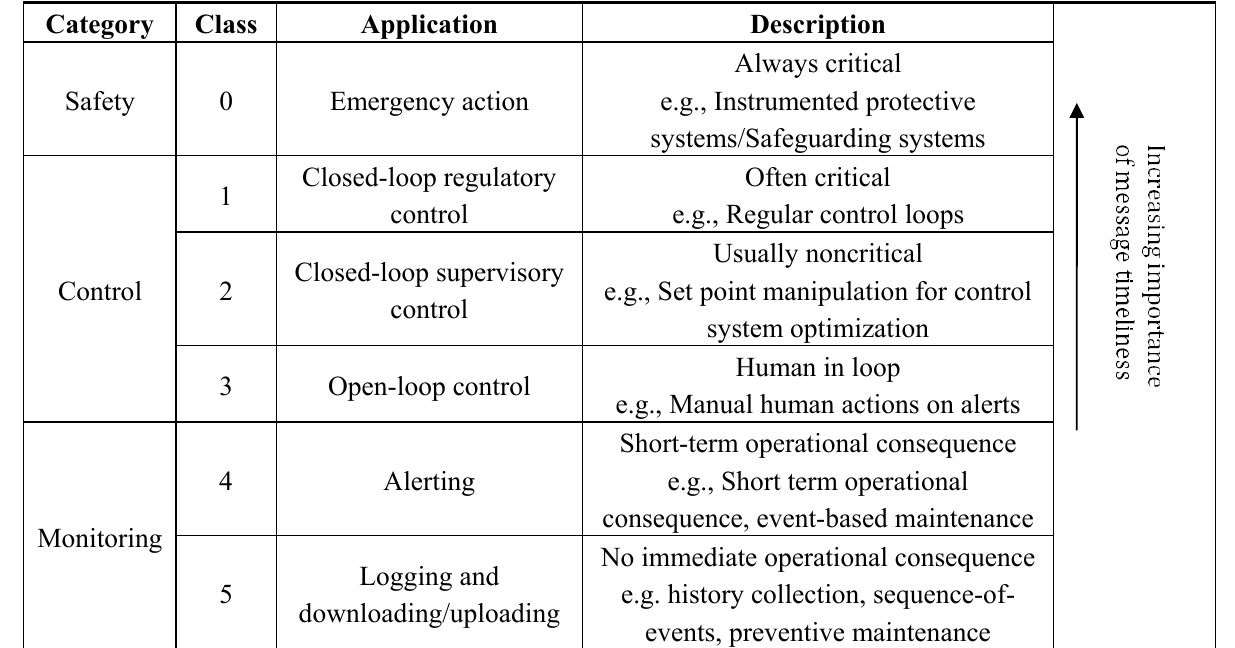
Table 2. Different classes of applications as defined by